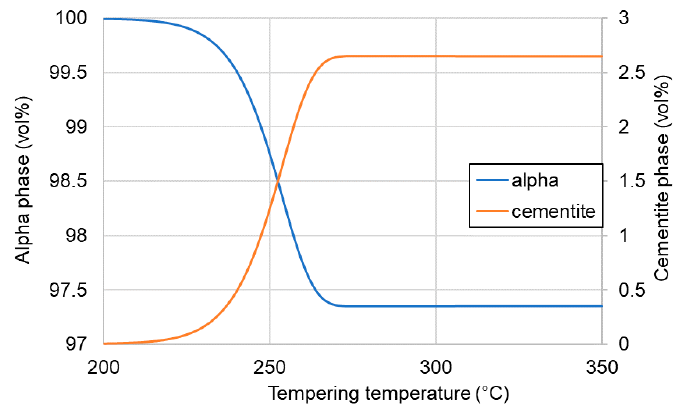
ff erent tempering temperatures.